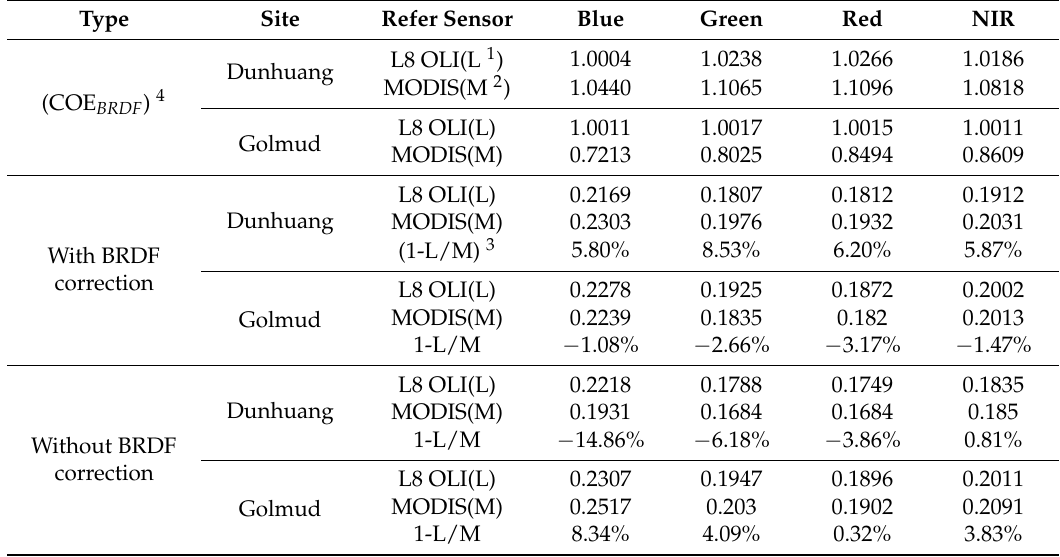
Table 4. BRDF correction coefficients, radiometric cross-calibration coefficients with and without BRDF correction at Dunhuang and Golmud test sites by using Landsat 8 OLI sensor and MODIS sensor, and the relative error of cross-calibration coefficients between the two